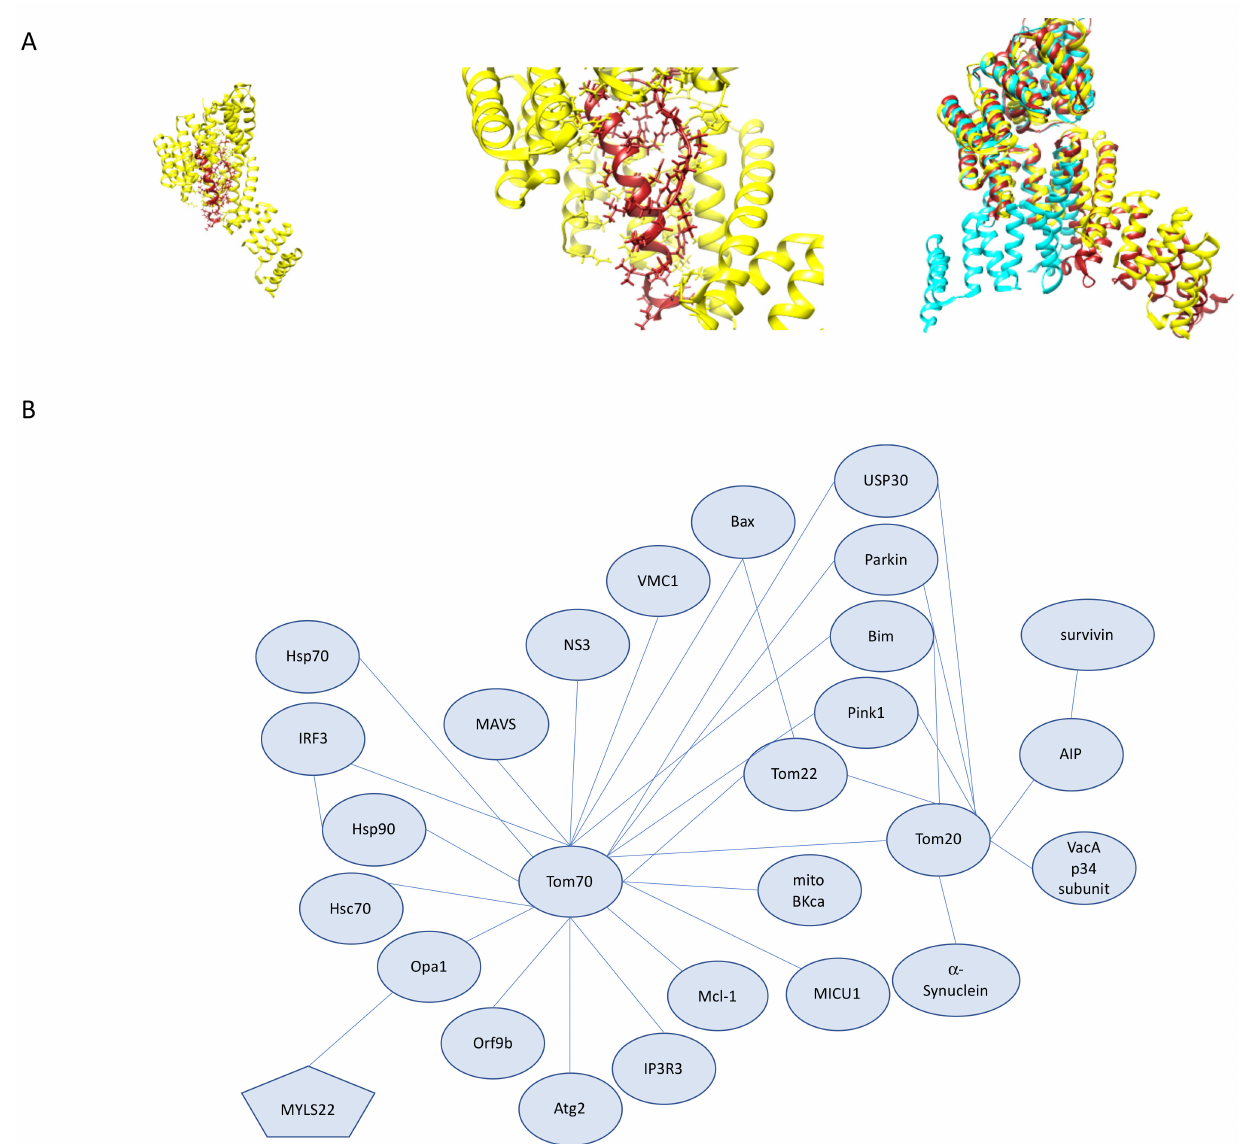
Figure 7. Tom20 and Tom70 Interactions. ( A ) Structure of human Tom70 bound to SARS-CoV-2 protein Orf9b. ( left ) Human Tom70 (yellow) binding pocket with Orf9b (red) bound. ( middle ) Closer view of Orf9b binding pocket with hTom70 (yellow) and Orf9b (red). ( right ) Superimposition of human Tom70 (yellow), yeast Tom70 (cyan) and yeast Tom71 (brick red). Superimposition highlights the rotation of the N-terminal domain between the fungal structures. ( B ) Tom70 and Tom20 interactions as described. Distances do not represent interaction